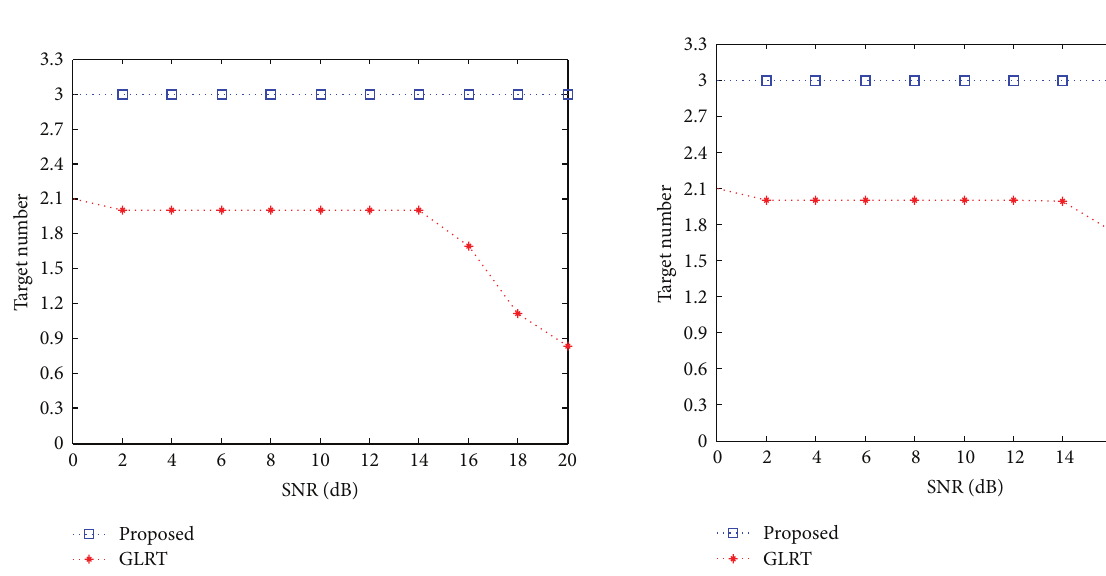
Figure 8: The number of estimated SOIs in case